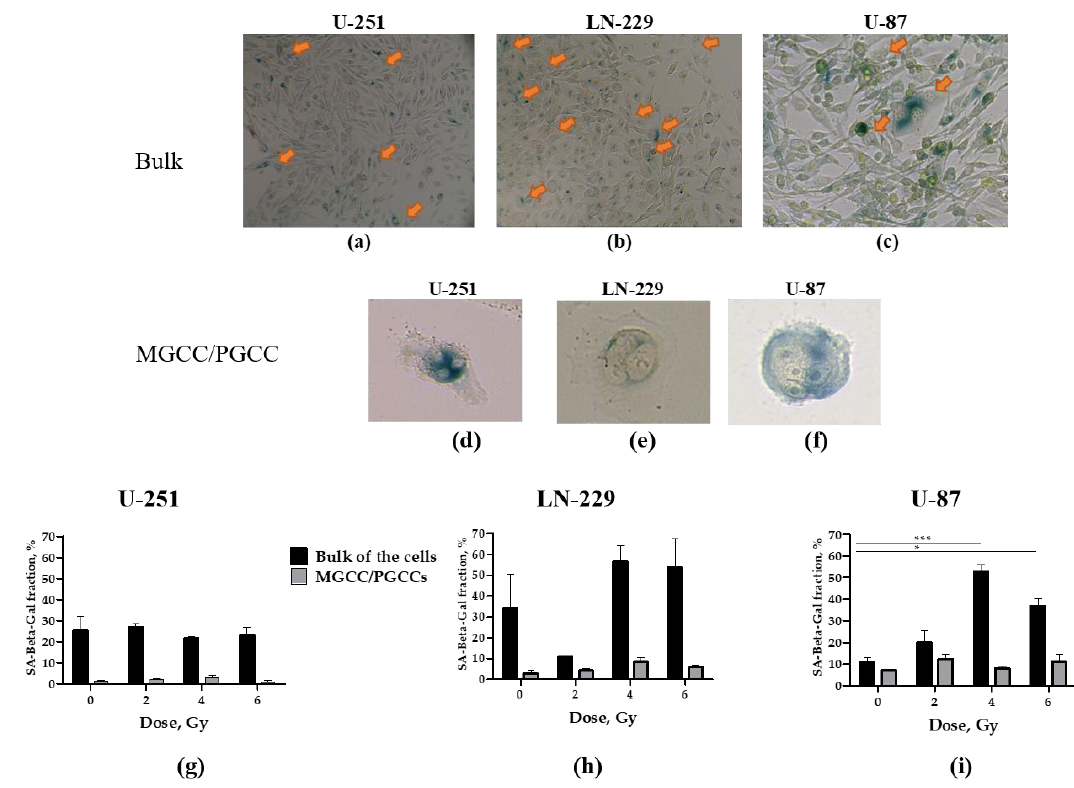
Figure 7. Senescence-associated β -Gal staining of GBM cells and their corresponding MGCCs/PGCCs 24 h after X-ray irradiation. Representative light microscopy staining images of SA- β -Gal cytochemistry showing SA- β -Gal positive cells (blue stain) at both the bulk GBM populations ( × 20) ( a – c ) and individual MGCC/PGCC ( × 40) ( d – f ). Orange arrows indicate SA- β -Gal + cells. The percentage of SA- β -Gal + cells in the same populations of ( g ) U-251, ( h ) LN-229, and ( i ) U-87 cells seeded at a concentration of 5 × 10 3 cells/0.32 cm 2 . * p ≤ 0.05, *** p ≤